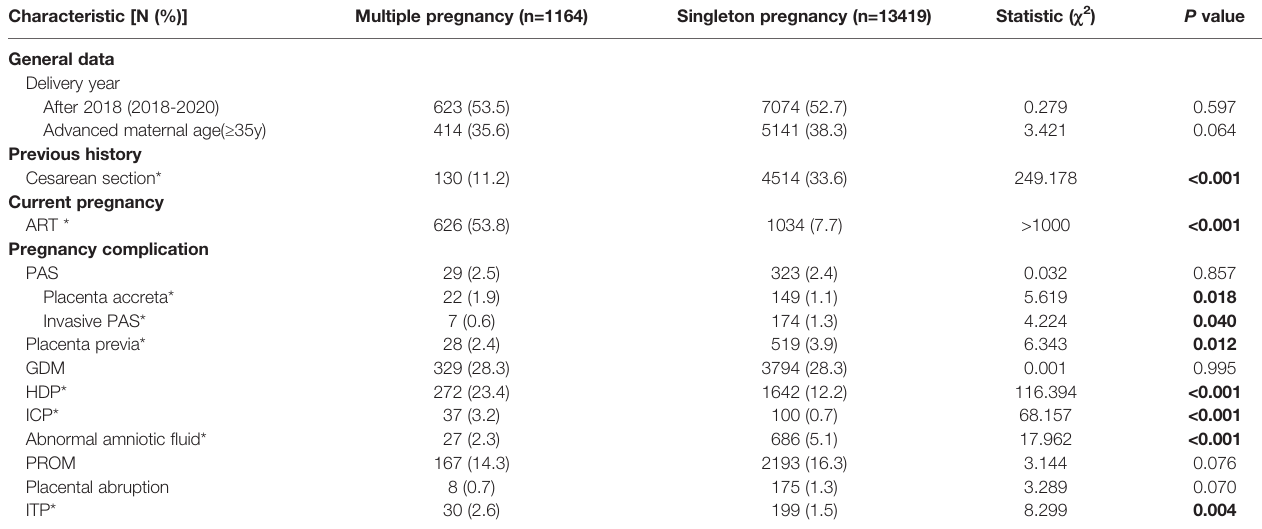
TABLE 1 | Patients ’ demographic and clinical characteristics